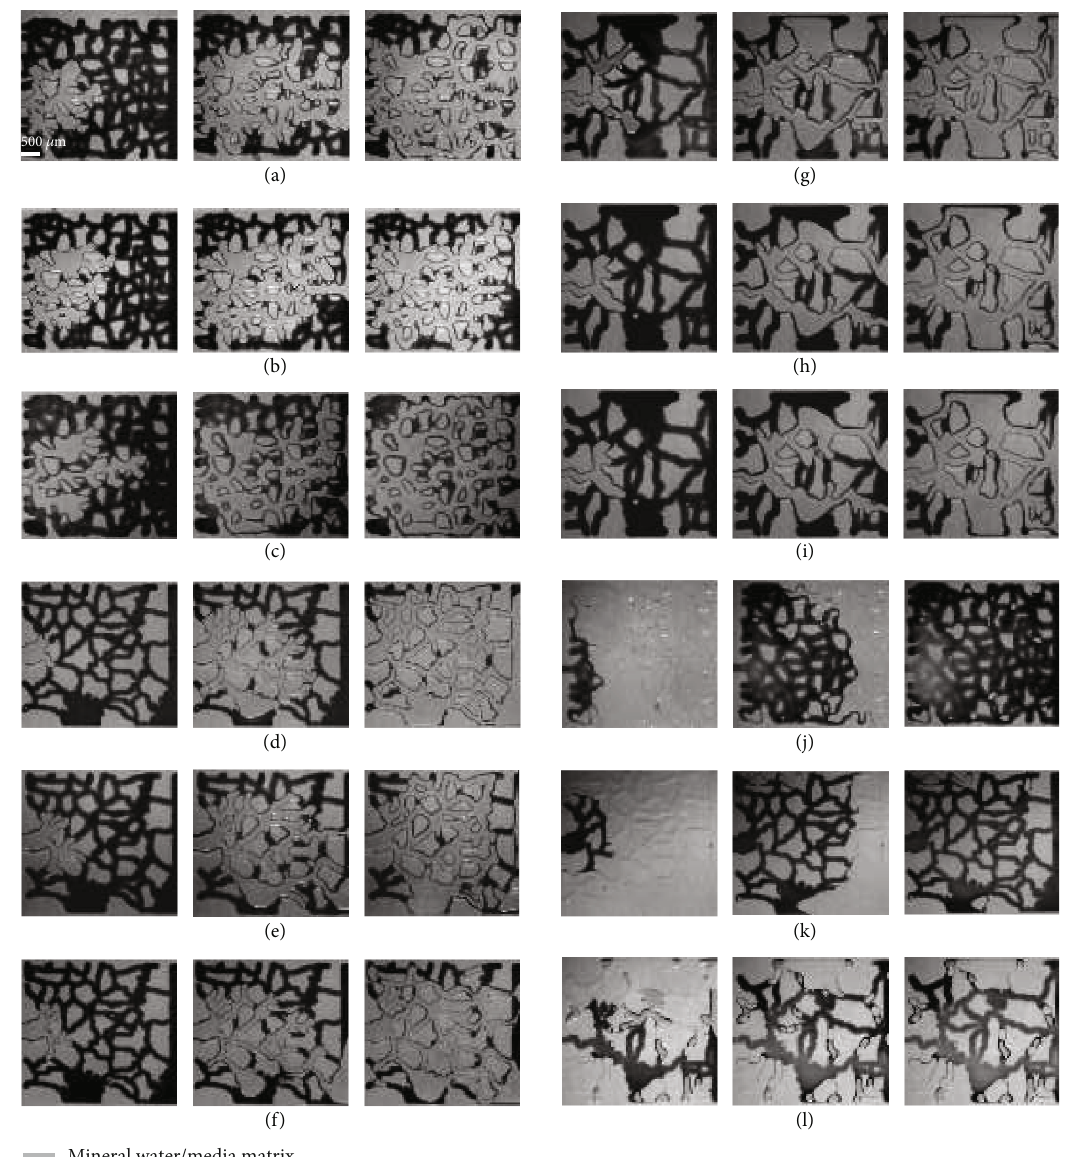
Figure 6: Experimental results of micro fl uidic two-phase fl ow